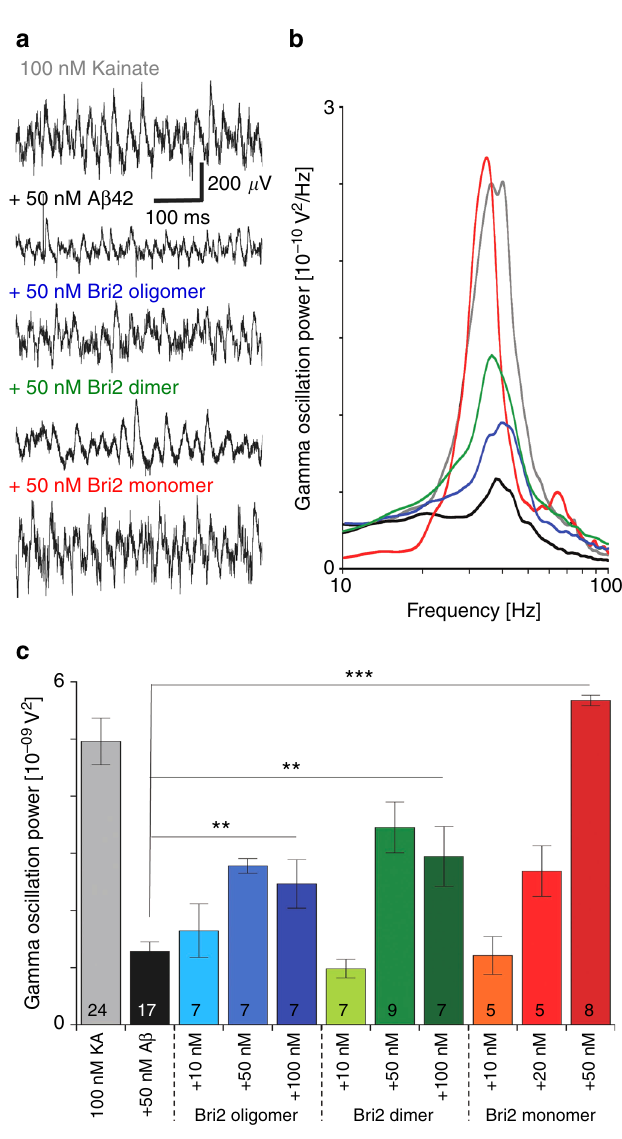
Fig. 5 Effects on A β 42 toxicity in mouse hippocampal slices of different rh Bri2 BRICHOS species. a Example traces of γ oscillations under control conditions (gray), after 15 min incubation with 50 nM A β 42 (black) and after 15 min incubation with 50 nM A β 42 + 50 nM oligomer, dimer or monomer (blue, green and red, respectively). b Example power spectra of γ oscillations under control conditions (gray), after 15 min incubation with 50 nM A β 42 (black) and after 15 min incubation with 50 nM A β 42 + 50 nM oligomer, dimer or monomer (blue, green and red, respectively). c Summary histogram of γ oscillation power under control conditions (gray), after 15 min incubation with 50 nM A β 42 (black) and after 15 min incubation with 50 nM A β 42 + three concentrations of oligomer, dimer or monomer (blue, green and red, respectively). The fi gures under the histograms denote number of biological replicates, and the data are reported as means ± standard errors of the